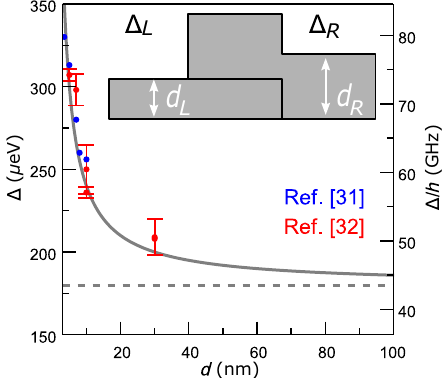
FIG. 1. The superconducting gap ( (cid:2) ) versus the thickness ( d ) in a typical Al thin film. For d (cid:2) 3 nm, the phenomenological dependence of the Al gap on the thickness d has been established to be (cid:2)( d ) = (cid:2) bulk + ad − 1 , where (cid:2) bulk (cid:3) 180 μ eV is the